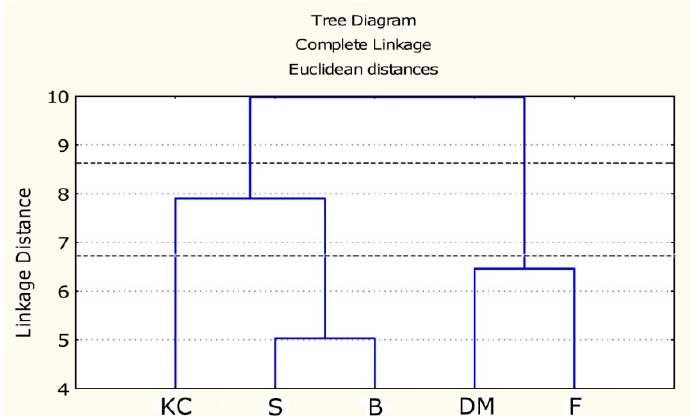
Figure 5. Dendrogram (TCA) showing the clustering, based on NMR data (both hydroalcoholic and organic metabolites quantified) of F: Fiaschetta, B: Bamano, DM: DulceMiel, S: Sugarland, KC: King Creole. Two levels corresponding to a different number of groups are marked.